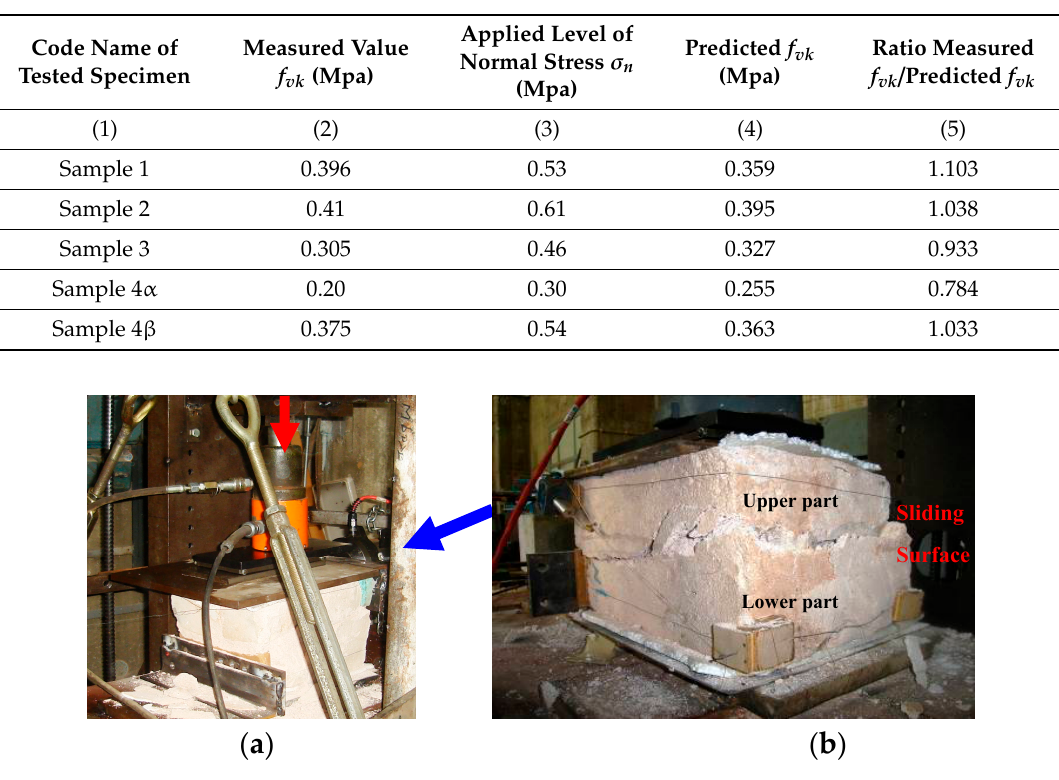
Figure 10. ( a ). Short stone masonry specimen subjected to sliding shear; ( b ) Sliding mode of failure of short stone masonry specimen.